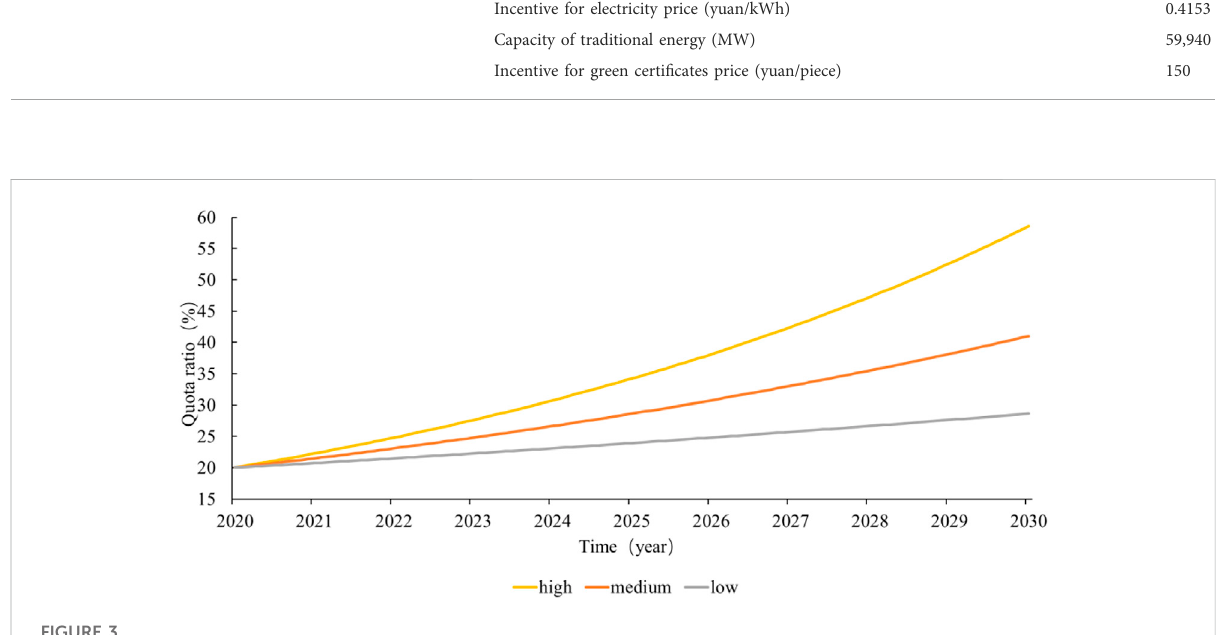
Figure 3. Three curves rise at different speeds and reach the highest points of 29%, 41%, and 59% by 2030 respectively.